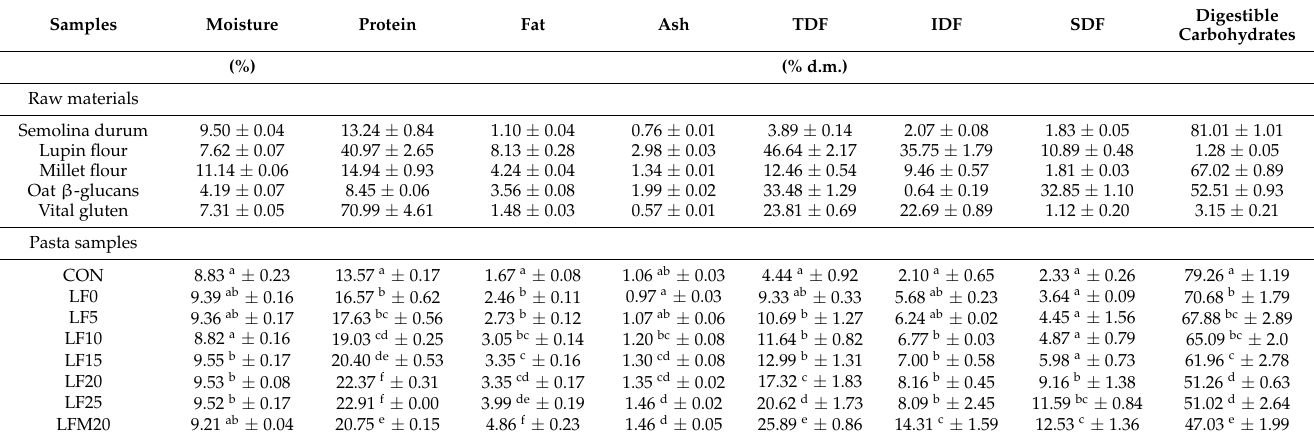
Table 2. Chemical composition of raw material and pasta